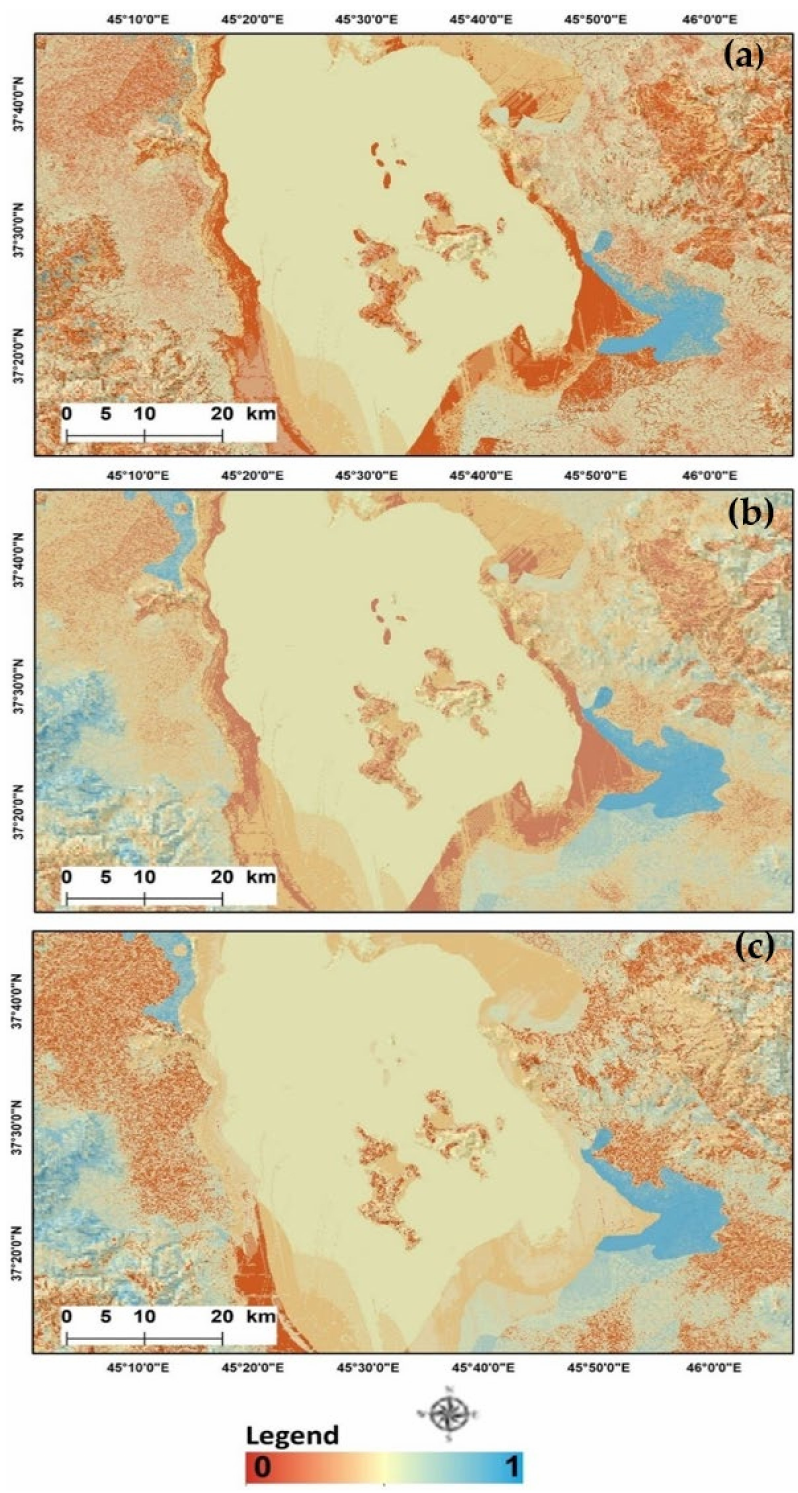
Figure 5. Results of MCS-based criteria weight sensitivity analysis, including: ( a ) computed maxi- mum rank, ( b ) average rank, and ( c ) standard deviation. These maps are based on the MCS sensitivity analysis of the computed criteria